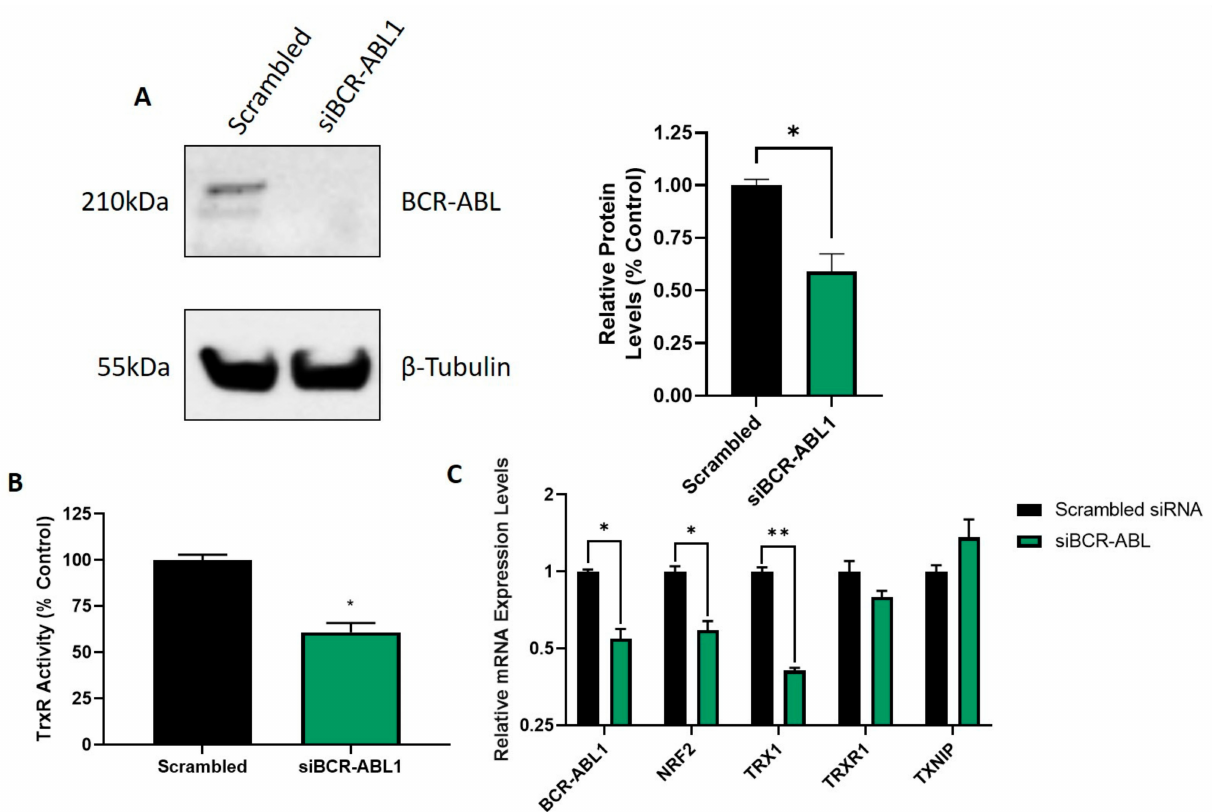
Figure 7. BCR-ABL knockdown results in a decrease in TRXR activity and mRNA expression. K562 CML cells were trans- fected with either BCR-ABL1 or scrambled siRNA and Western blotting ( A ) was performed after 5 days incubation following transfection to measure BCR-ABL protein levels. Densitometry analysis of Western blots is displayed as mean ± SD and was statistically analyzed via paired t tests. B-tubulin was used as a loading control. The displayed Western blot is representative of three repeats. Furthermore, transfected cells were incubated for three days and then either TRXR activity assays ( B ) or RT-qPCR ( C ) were performed. RT-qPCR was used to measure the mRNA expression levels of BCR-ABL1 , NRF2 , TRX1 , TRXR1 and TXNIP . RPL32 was used as a normalizer of mRNA levels. TRXR activity results were analyzed via a paired T-test and RT-qPCR data were analyzed via one-way ANOVAs with a Dunnett’s post hoc test. Statistical tests compared results between the BCR-ABL1 siRNA transfected cells and the scrambled siRNA transfected cells. * = p < 0.05, ** = p < 0.01. n = 3. Values displayed as mean ±